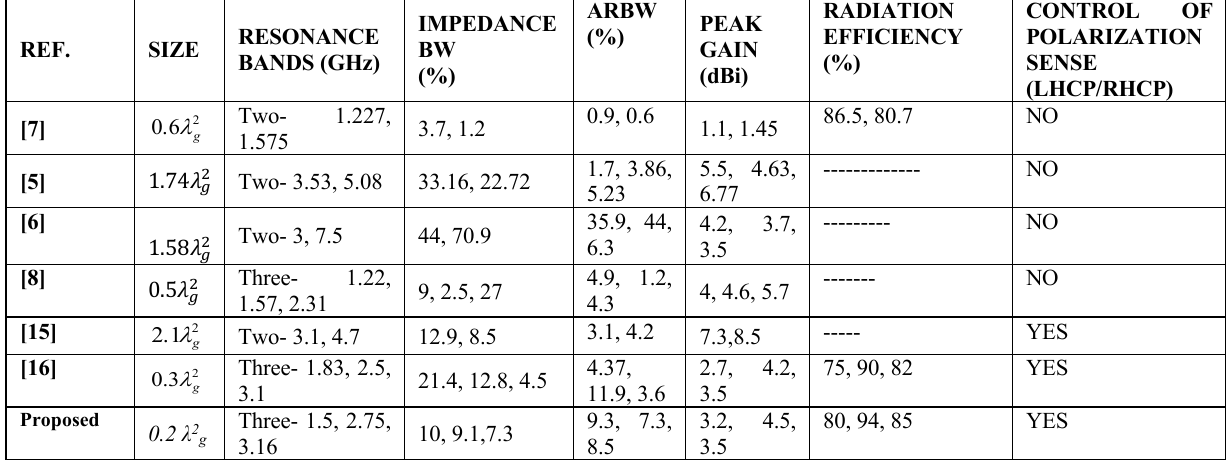
Table 1: Performance parameters of different multiband circularly polarized slot antennas (λ g -guided wavelength corresponding to the lowest resonant frequency)